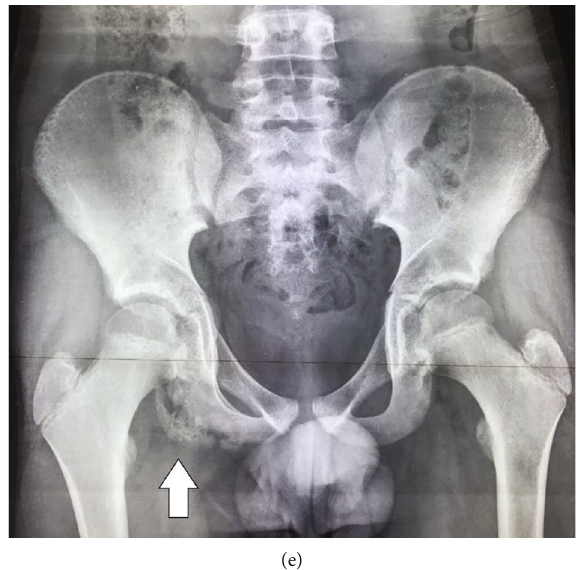
Figure 1: (a) On the right ischium, there is calci fi cation adjacent to the parental bone that has normal structure. (b – d) STIR sequence in transverse (b), coronal (c), and sagittal (d) plane of the pelvis in an adolescent with right hip pain. An asymmetric enlargement of the right ischial tuberosity is observed, with a semilunar osteocartilaginous mass separated from the body of the ischial tuberosity. A fl uid fi eld cavity is developed between the parental bone and the detached fragment, whereas concomitant edema of the surrounding muscles due to blood products is also observed. The conjoined hamstring tendon remains attached to the apophysis. (e) There is partial union of the calci fi ed osteochondral bone to the